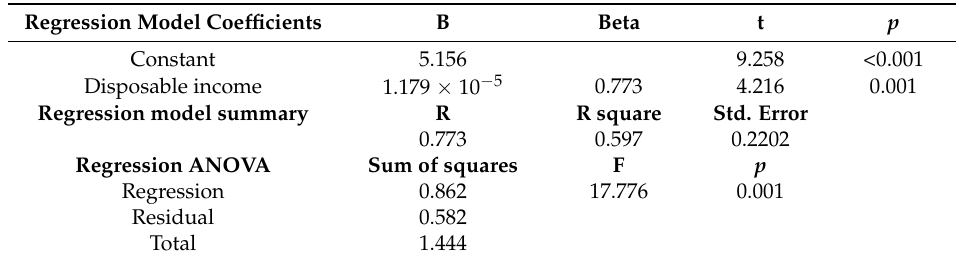
Table 3. Regression data between mean regional FAS score and disposable income of